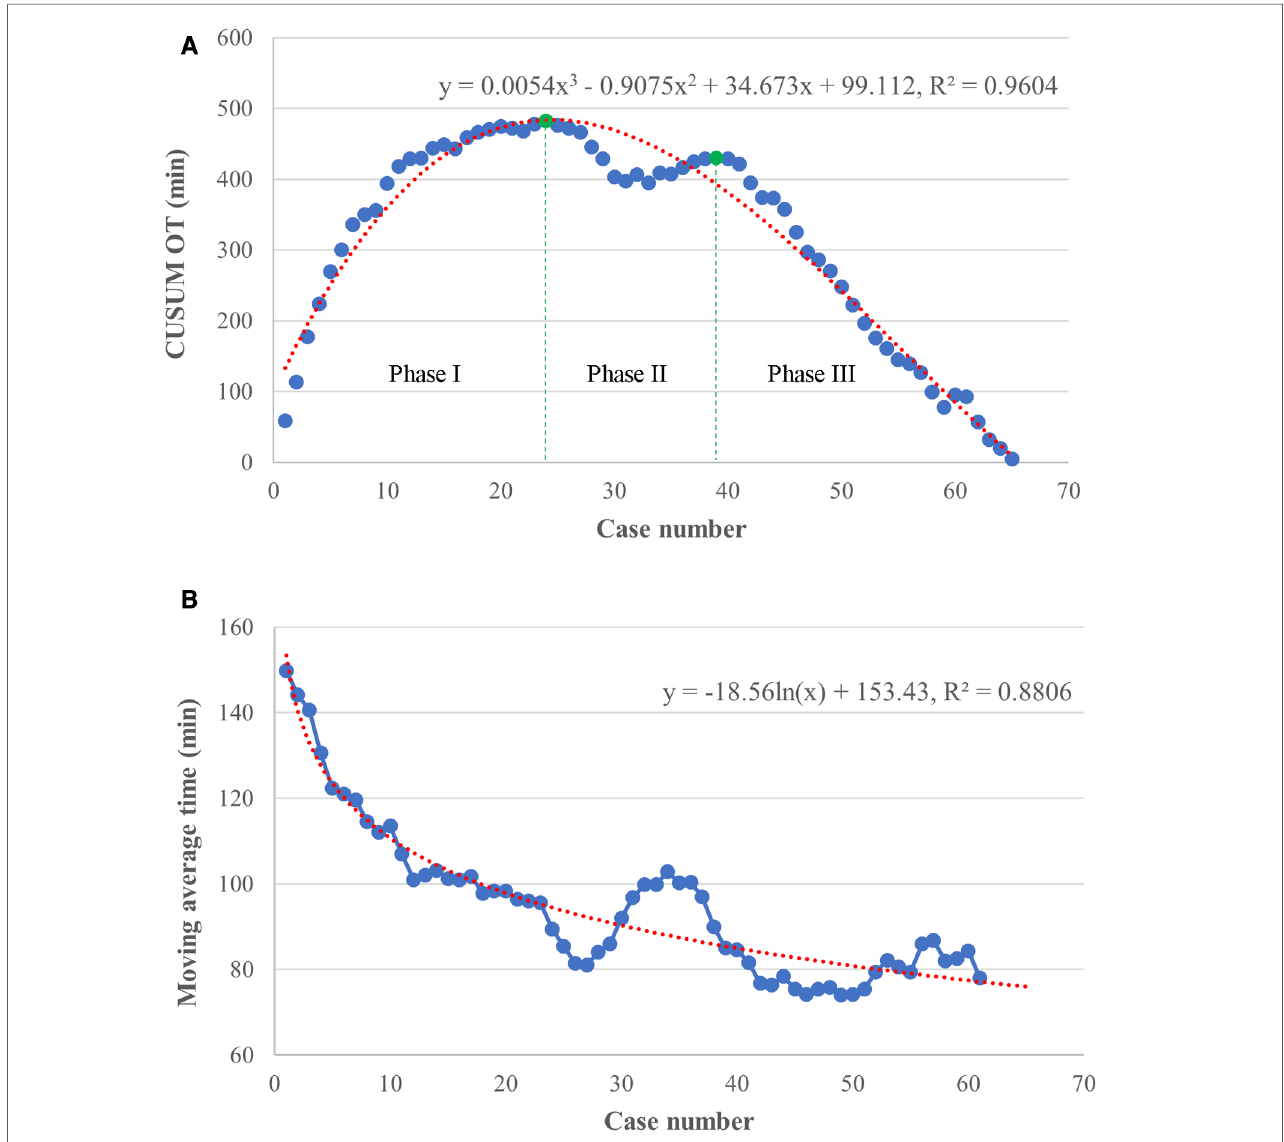
FIGURE 3 Results of cumulative sum (CUSUM) and moving average analyses based on operation time. ( A ) The CUSUM analysis of OT is best modeled by a red line as a third-order polynomial with equation y =0.005 x 3 – 0.907 x 2 +34.673 x +99.112, R ²=0.9604. The learning curve consisted of 3 unique phases (separated by green lines), as follows: an initial phase (case 1 – 24), a transition phase (case 25 – 39), and the pro fi cient phase (case 40 – 65). ( B ) The moving average curve exhibited a gradual decline and was fi tted with a logarithmic model of y = − 18.56 ln( x )+153.43, R